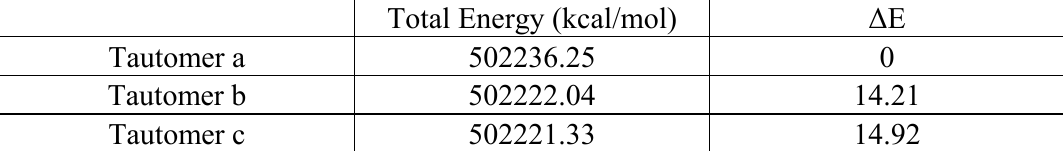
Table 4. Total Energy (a.u.) and relative energy for the four